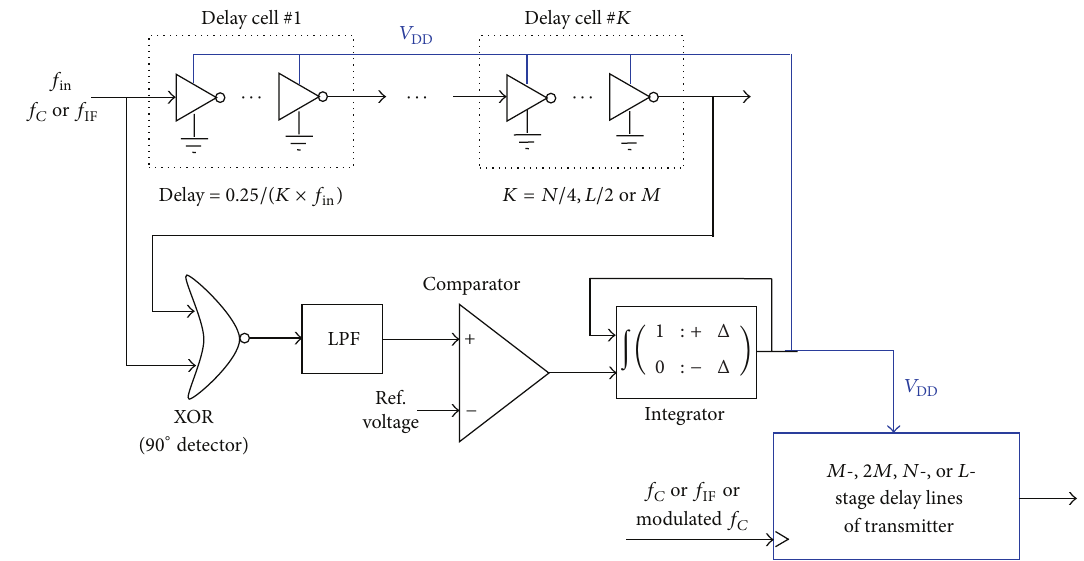
Figure 6: Proposed unit-delay autocalibration loop with reconfigurable 𝑓 𝐶